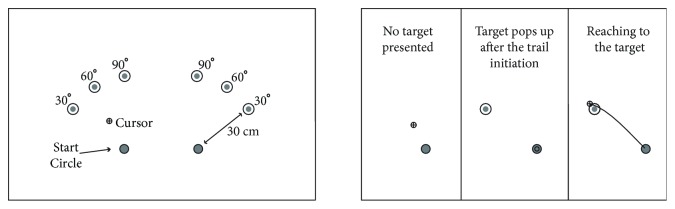
Experimental design.